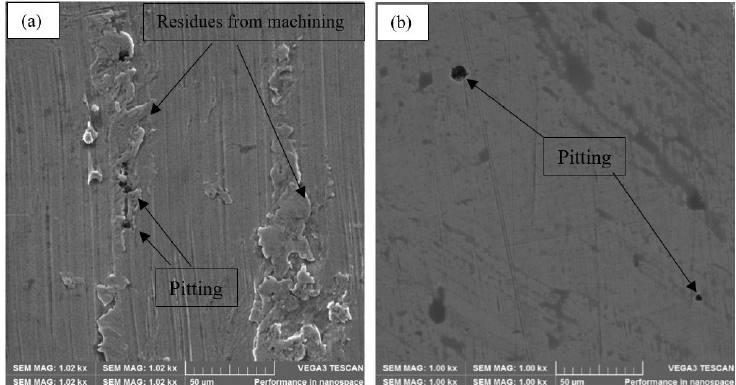
Figure 17. Samples of tests 2 (a) and 2P (b) with 1000X magnification.